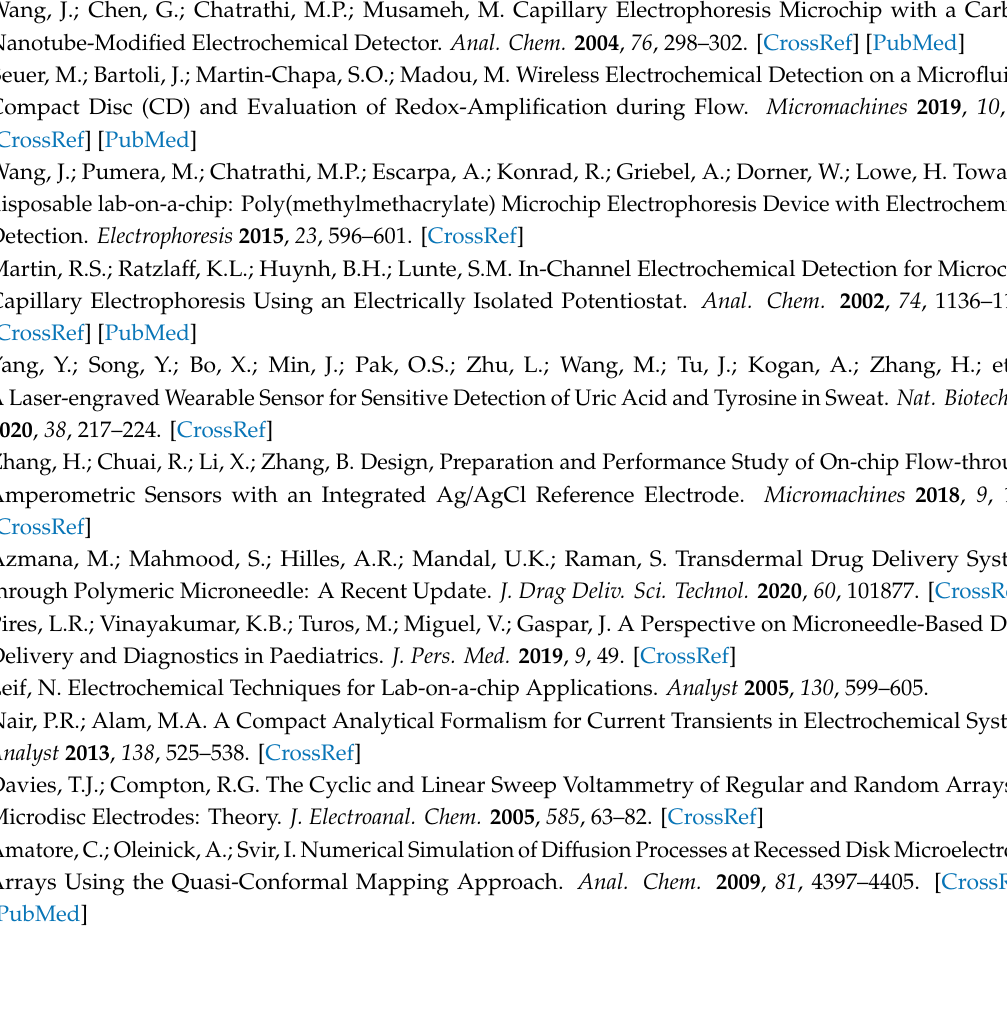
Figure S1: The schematic diagram of the electrochemical detection system, Figure S2: Concentration distribution in µ AE with the spacing of 200 µ m at di ff erent flow rates, Figure S3: Concentration distribution in µ AE with di ff erent spacings at the flow rate of 10 µ L / min, Figure S4: Concentration distribution of the µ AEs with micropillars of di ff erent heights and the planar electrode at the flow rate of 5 µ L / min, Figure S5: Concentration distribution of the µ AEs in di ff erent layouts at the flow rate of 10 µ L / min, Figure S6: Cross-section of the micropillars in di ff erent shapes, Figure S7: Experimental CA of the planar electrode and µ AE200 with di ff erent flow rates, Table S1: Parameters of the working electrode with di ff erent